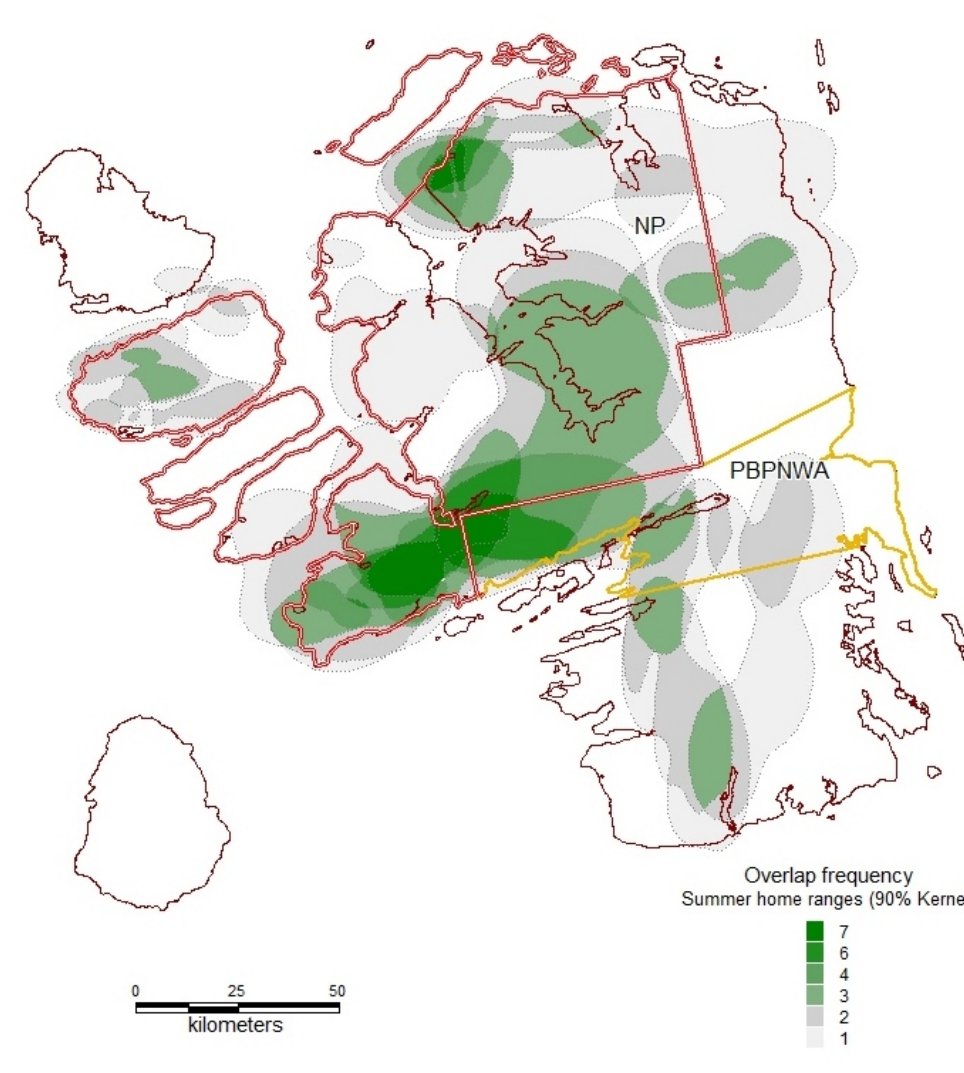
Figure 3. Summer individual female Peary caribou ranges for 2003–06 (unpubl. GN